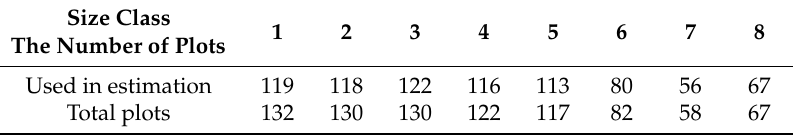
Table A2. Mortality rate estimation: the number of plots used for estimation. Size Class The Number of Plots Used in